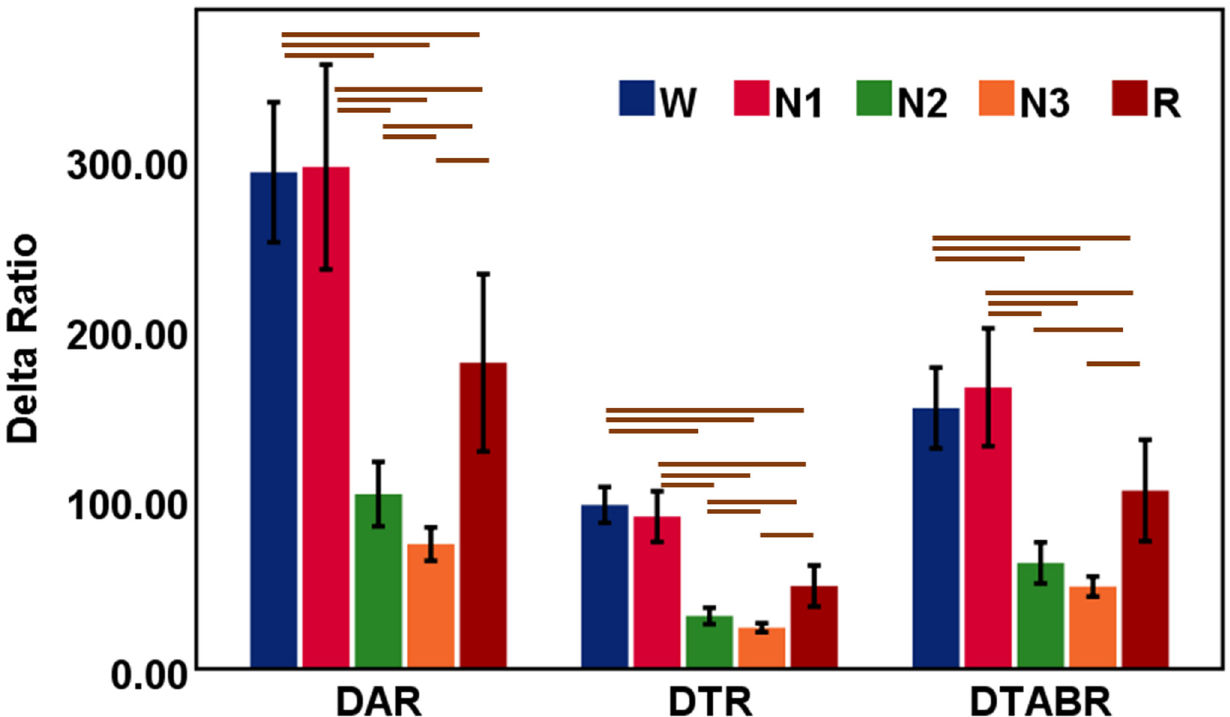
Figure 3. Results from DAR, DTR, and DTABR during sleep stages W, N1, N2, N-3, and R. The bar chart describes the relative mean power of the EEG waves and the vertical error bar (black color) is the 95% CI. Global indicates the average measures of features of the frontal, central, and occipital lobes. The horizontal bars (brown color) are the outcomes of the hypothesis tests and indicate significant differences (p < 0.05) in EEG features among the sleep stages.